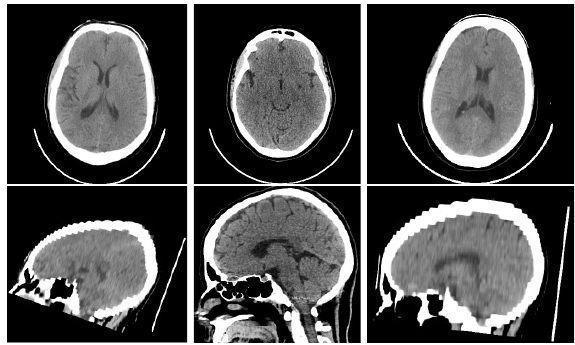
Figure 3. Three examples of head CTs in the CQ500 dataset.